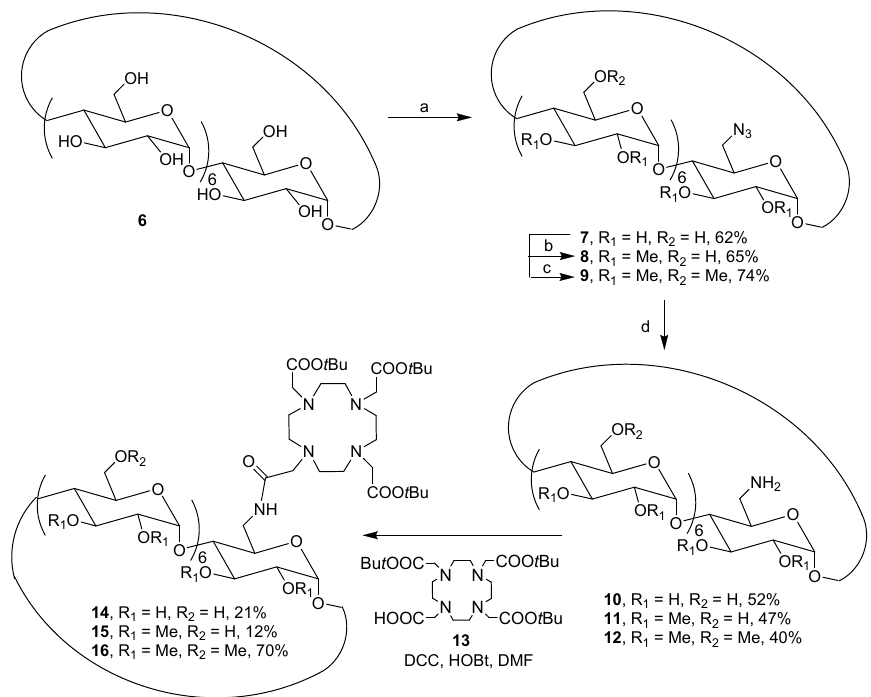
Scheme 1. Synthesis route of 6- O -monoamino- β -cyclodextrins precursors 10 – 12 and DOTAMA derivatives 14 – 16 .